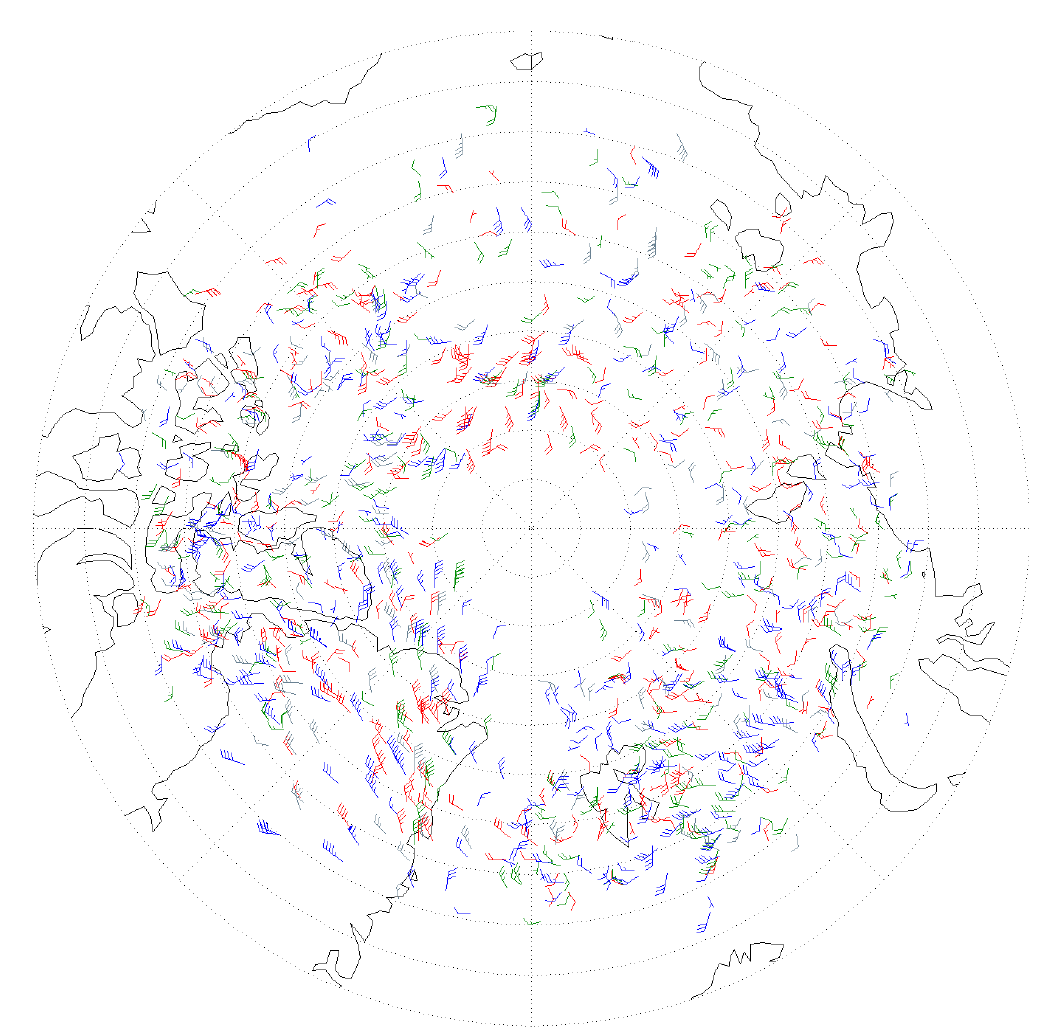
Figure 5. All derived winds from 5 January 2011 color-coded by level: 700–600 hPa (red), 550–450 hPa (green), 400–300 hPa (blue), 150 hPa ozone (gray).